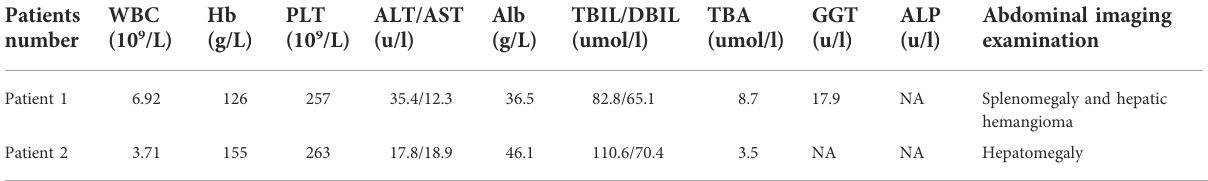
TABLE 1 Clinical laboratory tests and imaging examinations in the patients with Dubin – Johnson syndrome. Patients number